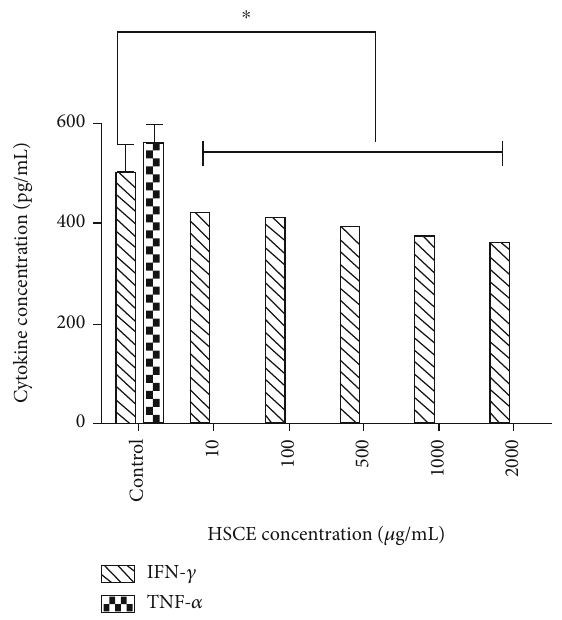
Figure 5: E ff ect of the Haliclona ( Soestella ) sp. sponge crude extract (HSCE) on ex vivo cytokine secretion by rat bone marrow cells (BMCs) ð ∗ p < 0 : 05 ; Mann ‐ Whitney U test Þ (IFN- γ : interferon gamma; TNF- α : tumour necrosis factor alpha). Table 2: E ff ect of oral administration of the HSCE on hepatic and renal parameters of rats.